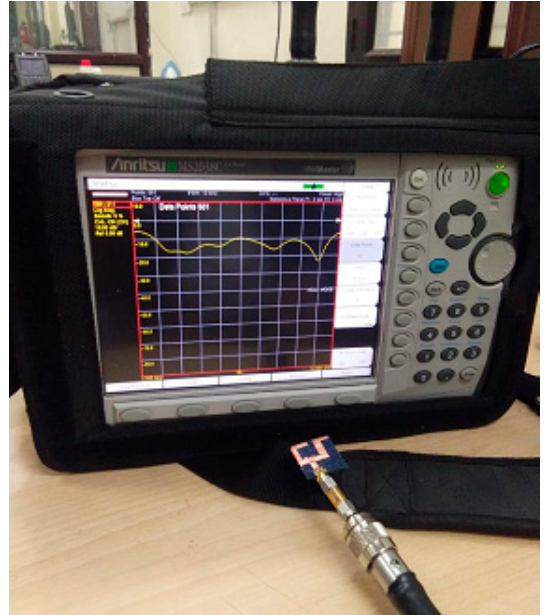
Figure 9. Measurement through the Vector Network Analyzer (VNA Anritsu MS2038C).